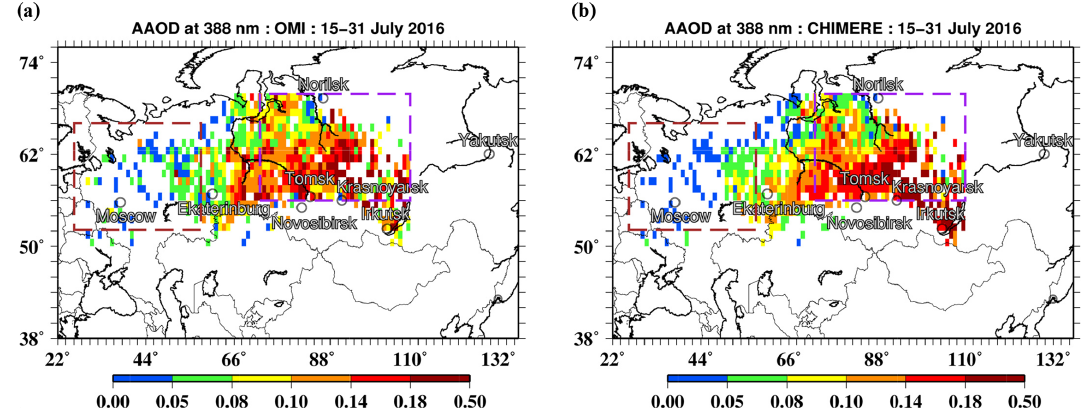
Figure 3. Spatial distributions of temporal averages of AAOD (at 388nm) in the period from 15 to 31 July 2016 according to (a) the OMI observations and (b) CHIMERE simulations for the bb_vbs scenario. The AAOD data represent only BB aerosol in the study region according to the selection criterion specified in the OMAERUV data product. The rectangles depict the source and receptor regions as in Fig.